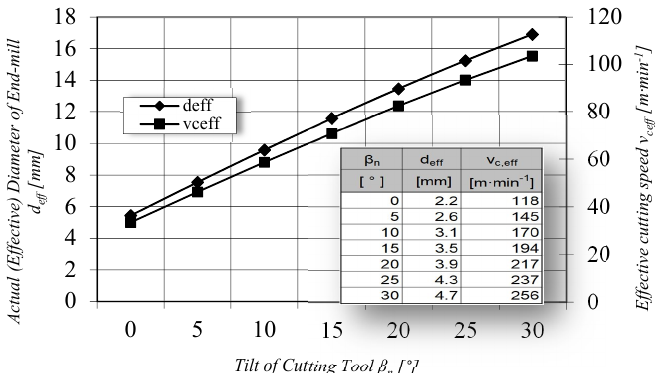
Figure 7. The dependence of the effective cutting speed v ceff and the effective tool diameter d eff at the tool axis inclination angle β n , (d = 6 mm, a p = 0.2 mm, v c = 330 m·min − 1 , n = 17,500 min − 1 ). Table 1. Technological parameters of the cutting